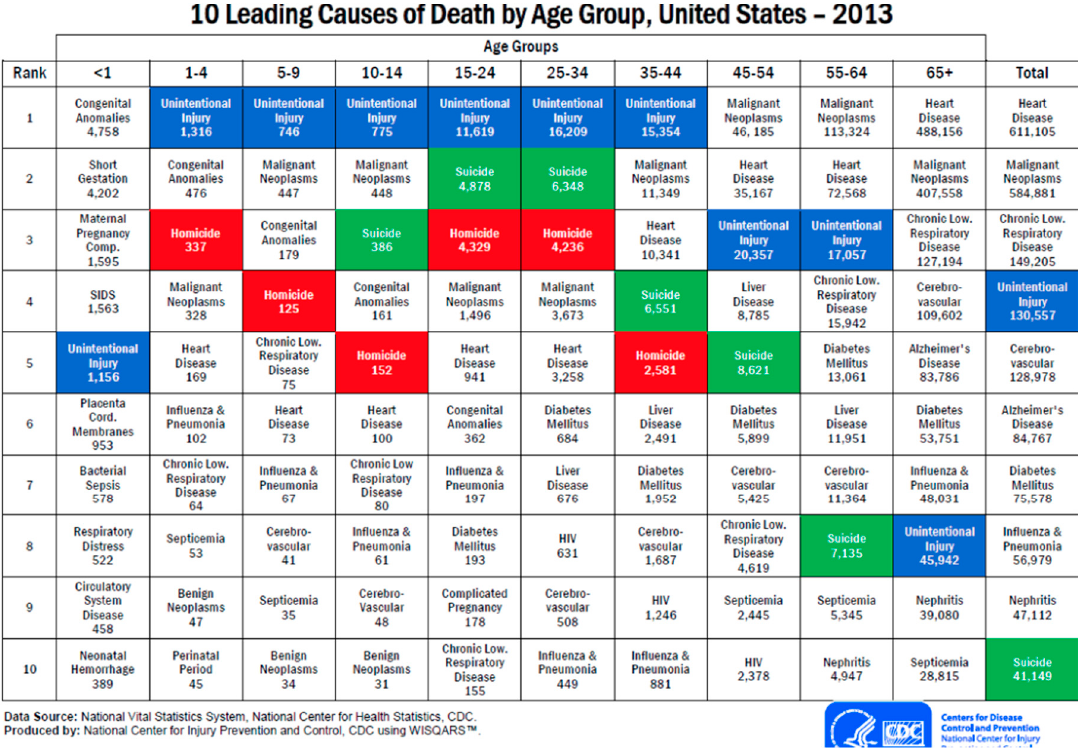
Figure 1. Leading causes of death by age [3].